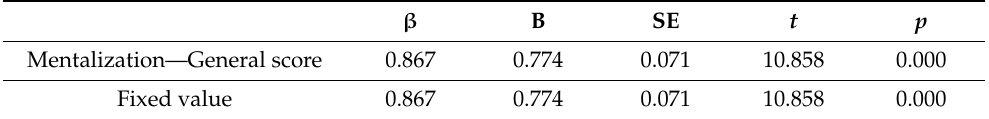
Table 6. Predictors of anxious preoccupation.